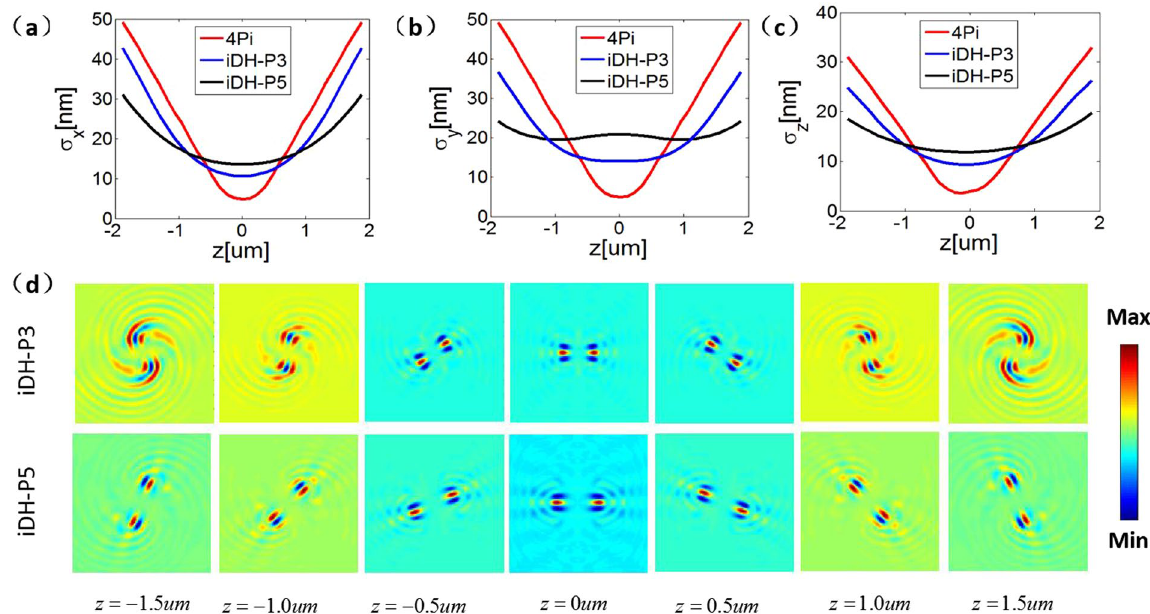
Figure 3. ( a – c ) Theoretical localization precision σ x , σ y , σ z using the 4Pi, and the iDH PSF (iDH-P3, iDH-P5) respectively. The depth range is extended as indicated by the flatness of the curves. ( d ) Images of iDH PSFs (iDH-P3, iDH-P5) over the 3 μ m depth